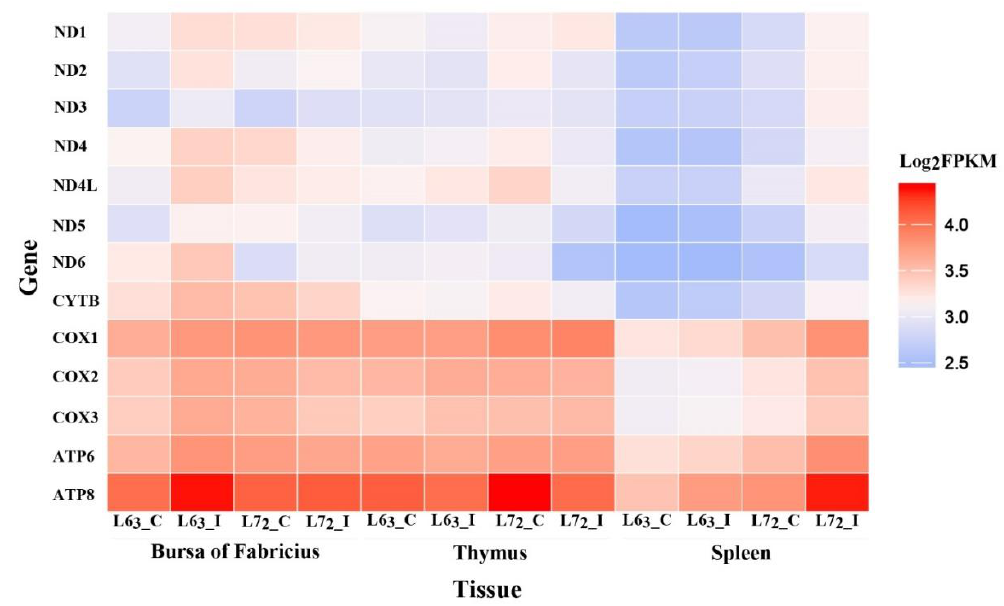
Figure 2. The expression of the 13 mtDNA protein coding genes. The average fragments per kilobase of transcript per million (FPKM) value of the two replicates was used as the gene expression and the heatmap was plotted based on log 2 FPKM. Each row represents an individual gene and each column represents the tissue and group type. The color legend represents the characteristic level, with red indicating high expression level and the blue indicating low expression level. Color density indicates di ff erent range of Log 2 FPKM. Table 1. Di ff erentially expressed mitochondrial DNA genes in three lymphoid